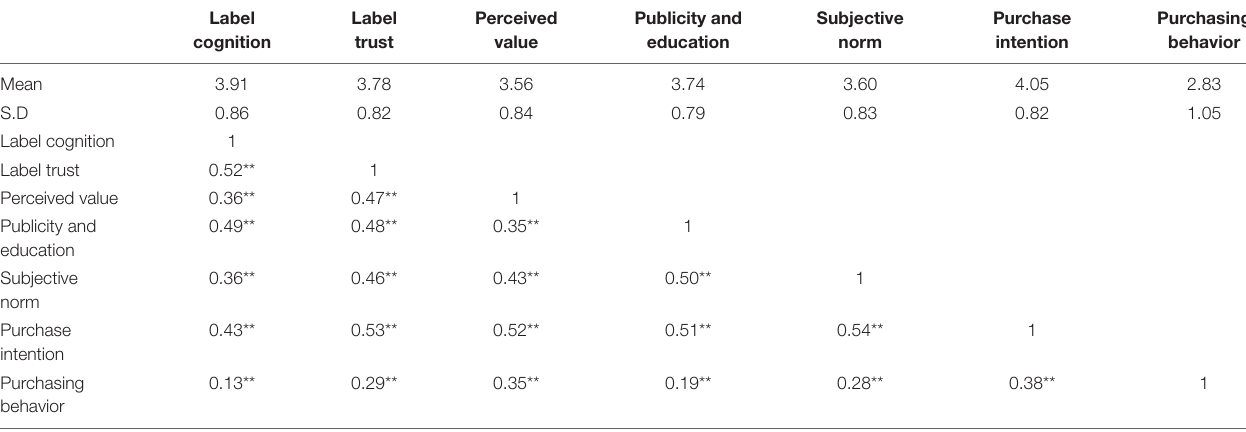
TABLE 2 | Variable mean, standard deviation, and correlation coefficient.